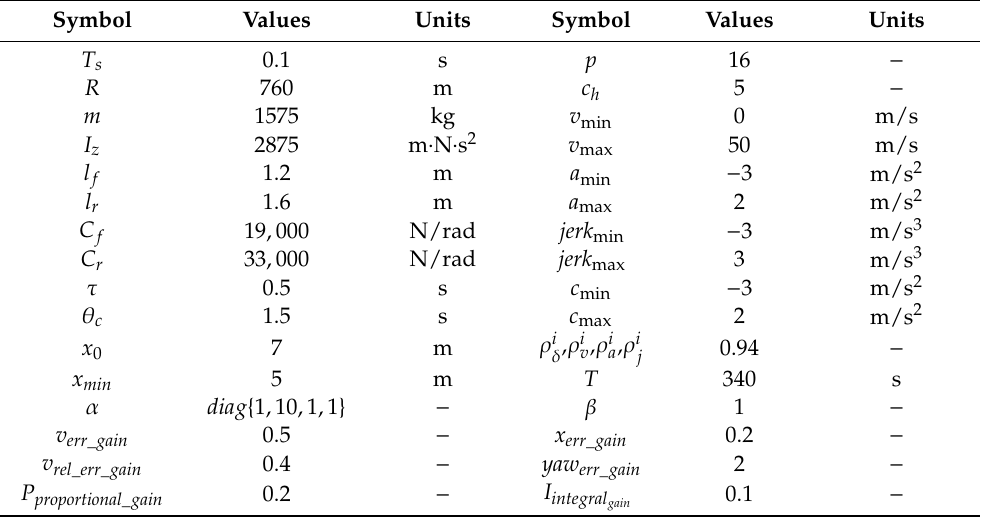
Table 1. Input parameters used in the simulation.